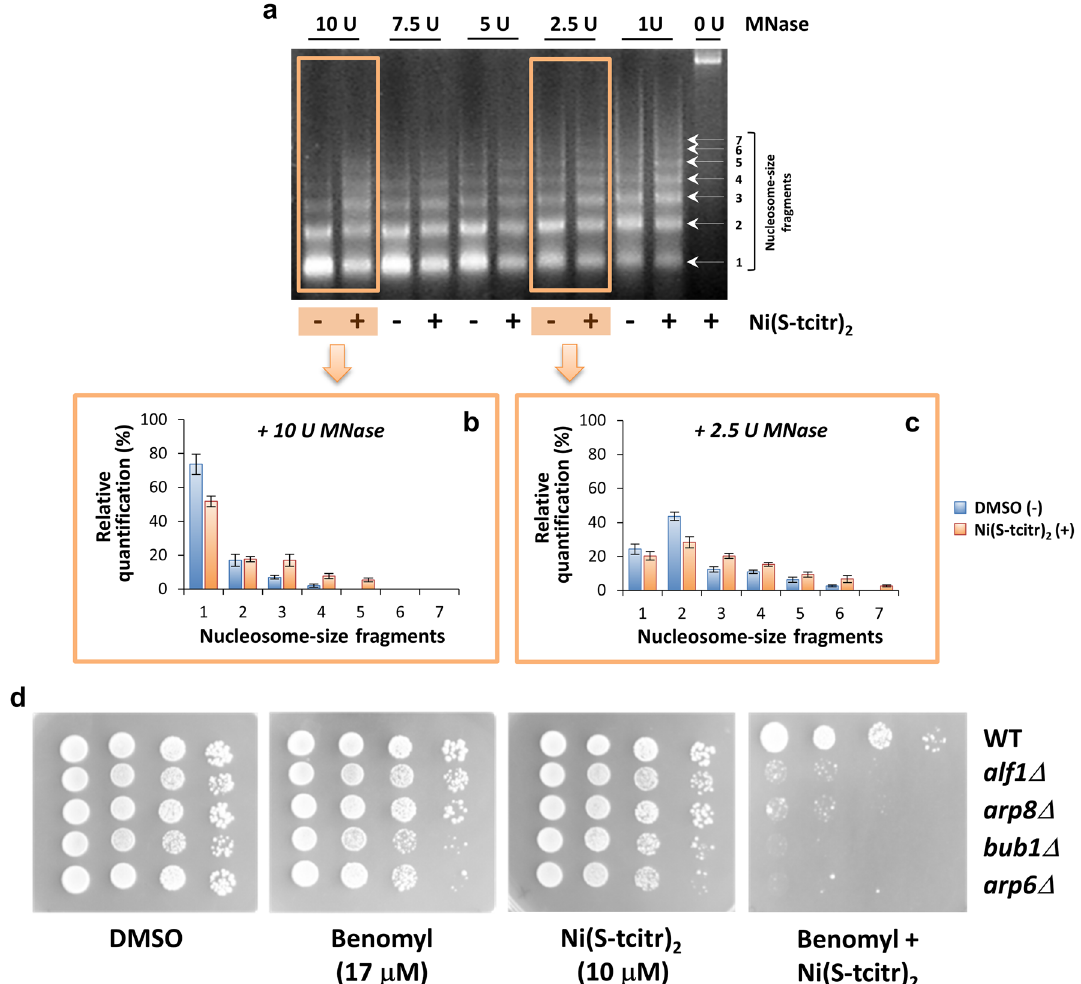
Figure 3. Ni(S-tcitr) 2 affects chromatin remodeling and microtubule cytoskeleton functionality. ( a ) Effect of Ni(S-tcitr) 2 treatment on in vivo chromatin remodeling. Equal amounts of spheroplasts from yeast cells treated with Ni(S-tcitr) 2 or DMSO (vehicle) were subjected to chromatin digestion with micrococcal nuclease (MNase); purified DNA was then fractionated by agarose gel electrophoresis and visualized by ethidium bromide staining (see ‘Methods’ for details). A representative gel picture shows different patterns of MNase digestion products. ( b,c ) Relative quantification of nucleosome-size fragments obtained from digestion of Ni(S-tcitr) 2 -treated and control (DMSO) chromatin samples with high (10 U; b ) or low (2.5 U; c ) amounts of MNase. ( d ) Synergistic toxicity of Ni(S-tcitr) 2 and the antimicrotubule drug benomyl. Ten-fold serial dilutions of wild-type (WT) cells and yeast mutant strains deleted in genes coding for chromatin remodeling ( arp6Δ and arp8Δ ), microtubule ( alf1Δ ) or cell cycle checkpoint components ( bub1Δ ) were plated onto YPD agar plates containing sublethal concentrations of benomyl (17 µM) and /or Ni(S-tcitr) 2 (10 µM) as indicated, and incubated for 2 days at 28 metabolic mutants involved in threonine metabolism ( hom3Δ , hom2Δ and thr4Δ ). As shown in Fig. 4a, a syner- gistic effect was observed upon treatment with both Ni(S-tcitr) 2 and HU.